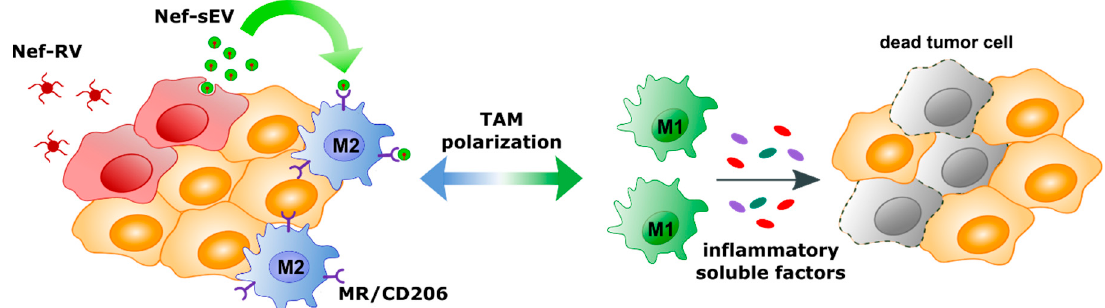
Figure 7. Scheme of the proposed mechanism for TAM reprogramming. Tumor cells are transfected with retroviral vectors expressing Nef mut (Nef-RV). Nef-engineered sEVs (Nef-sEV) are then released into the TME infiltrated with M2 like macrophages expressing the mannose receptor (MR/CD206). MR mediated uptake of Nef-Sev might induce polarization of M2 into M1 like macrophages—ultimately leading to the release of pro-inflammatory factors.